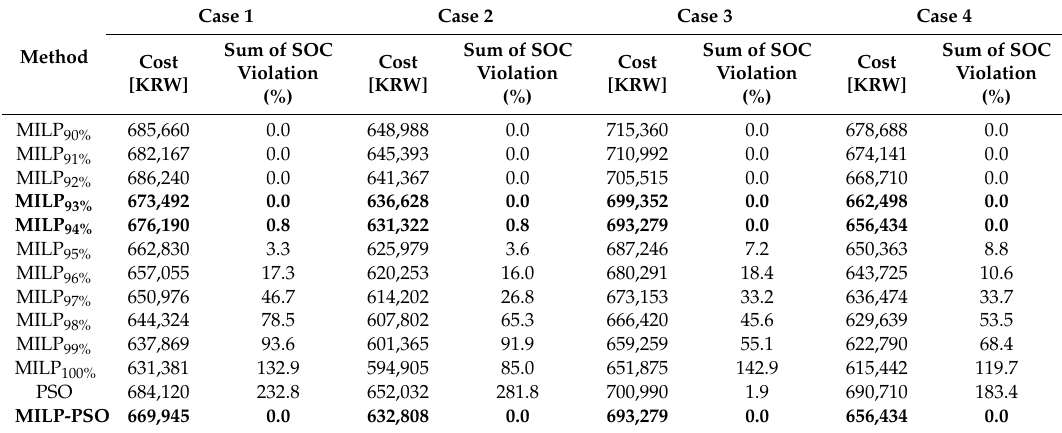
Table 2. Simulation results of cost and state of charge (SOC) violation.